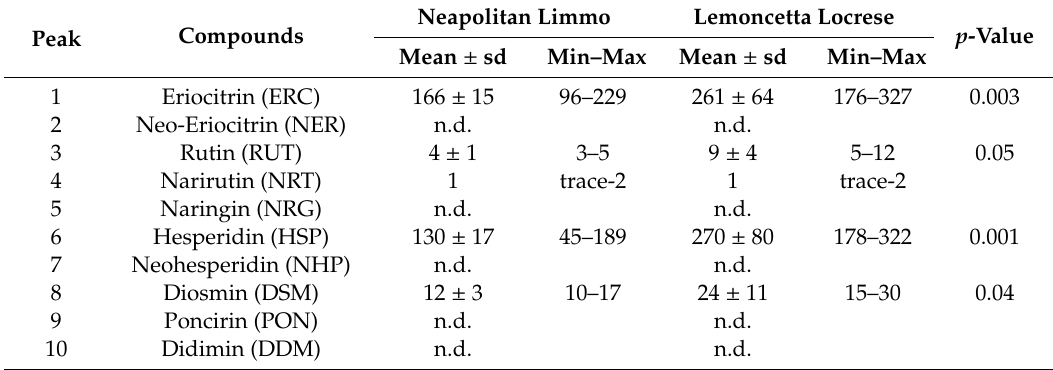
Table 1. Flavonoid content (mg / Kg) in Neapolitan limmo and lemoncetta Locrese estimated by HPLC. (n.d. ≤ 0.5 mg / Kg). Neapolitan Peak Compounds